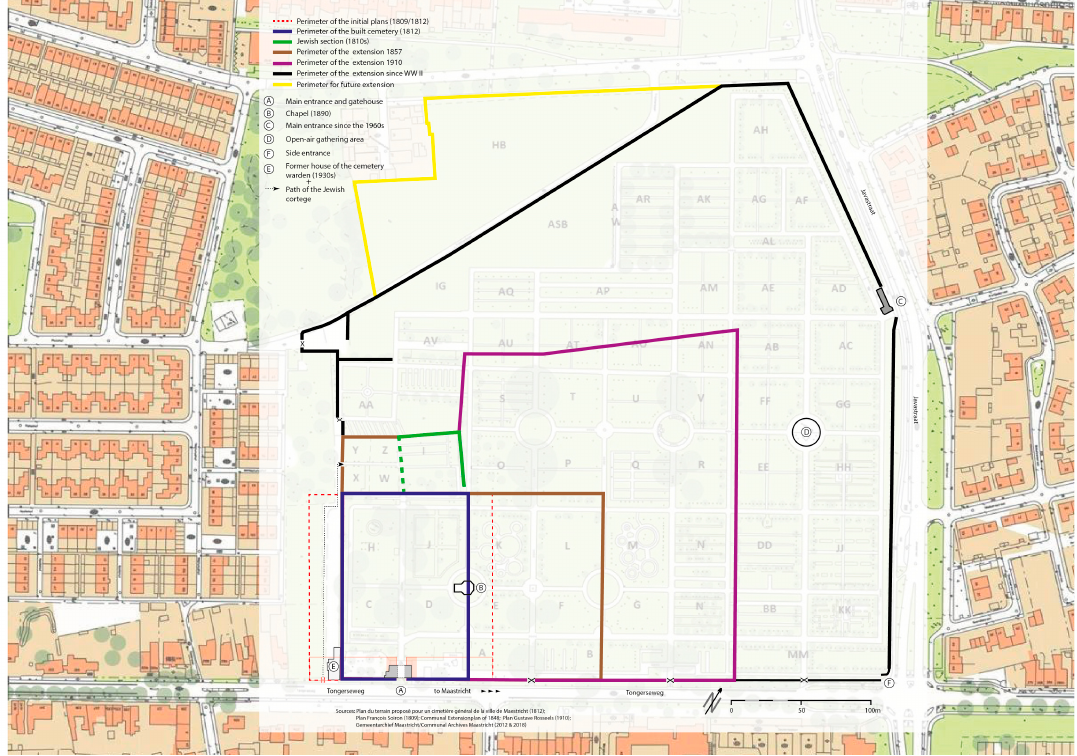
Figure 1. Schematic map of the development of Cemetery Tongerseweg